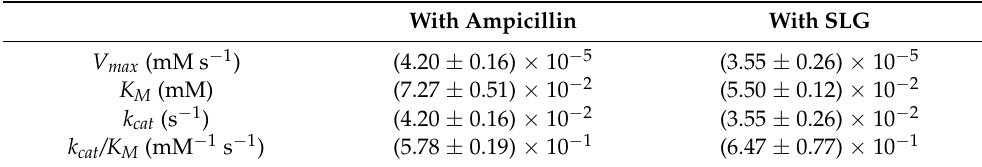
Table 1. Kinetics parameters of BLEG-1 towards ampicillin and SLG.